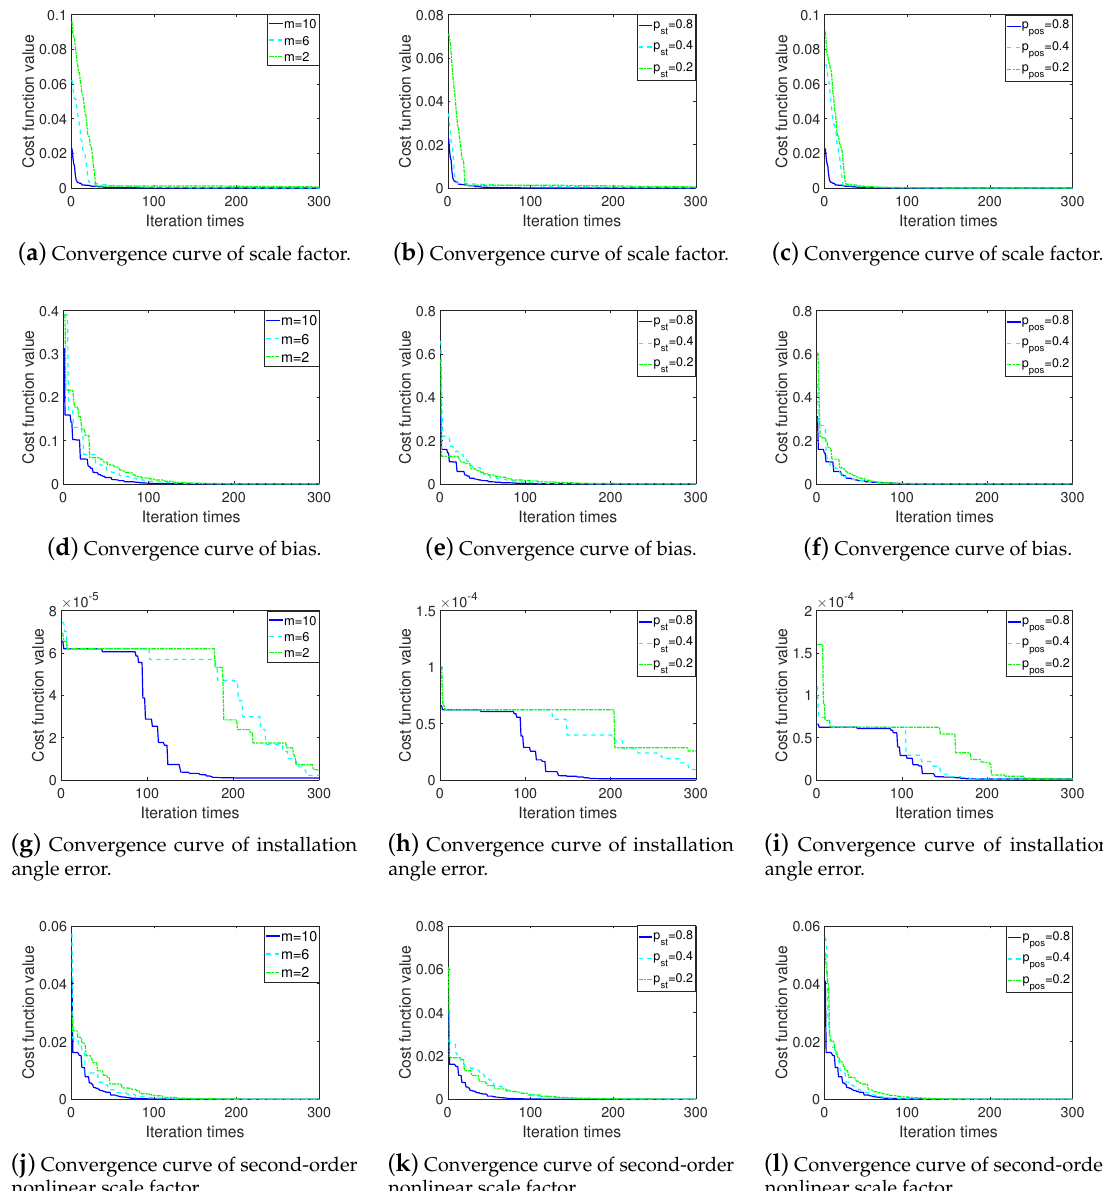
( j ) Convergence curve of second-order ( k ) Convergence curve of second-order nonlinear scale factor. nonlinear scale factor. Figure 3. Convergence curve of BSAS with different